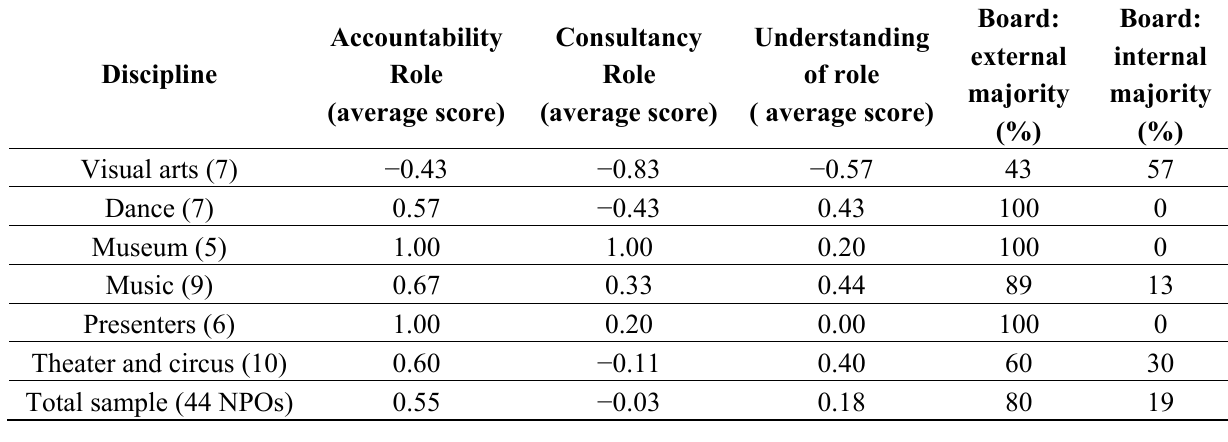
Table 11. Understanding of governance: Total sample and by